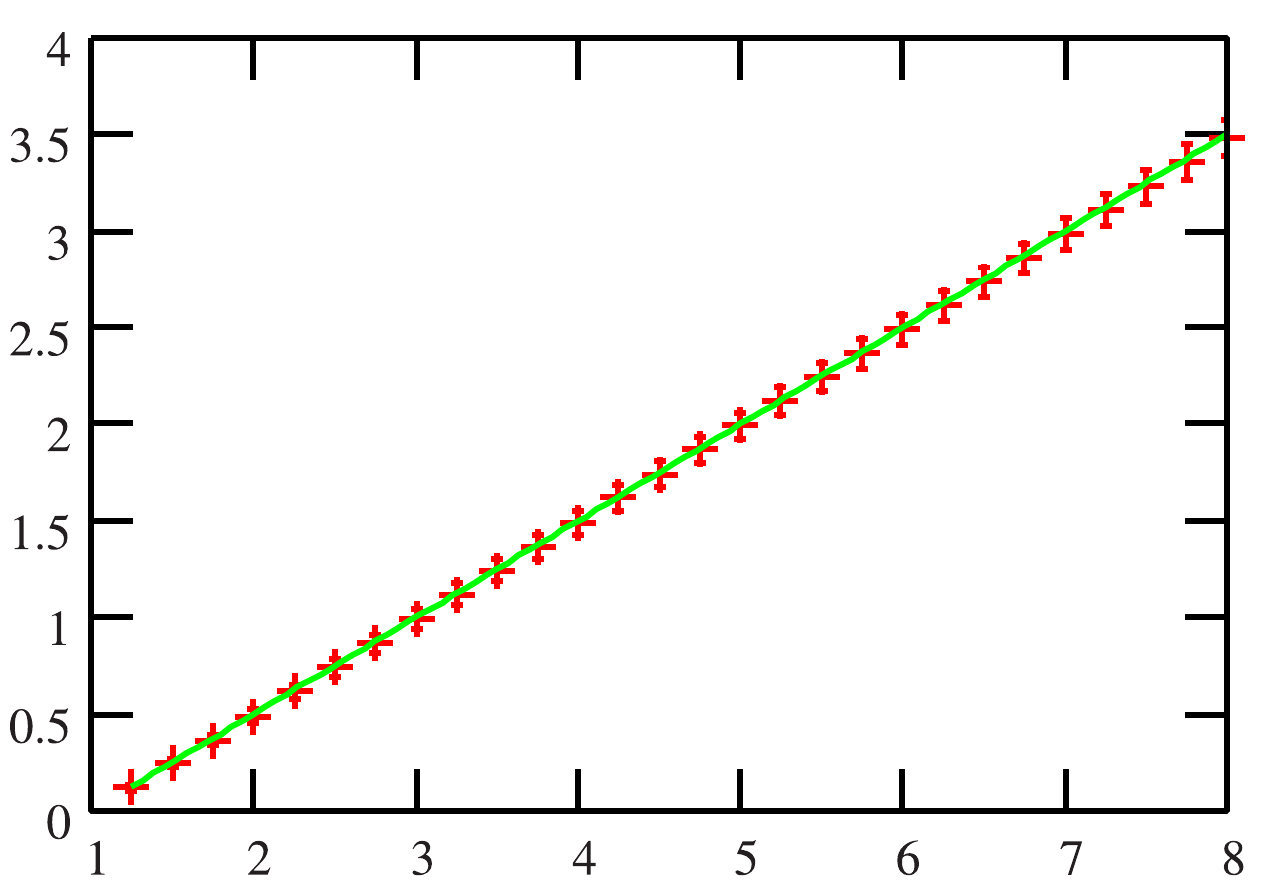
Fig 2. The reference ratio α (horizontal axis) versus one degree of the cost function ε (vertical axis). This result also indicates that the approximation approach based on probabilistic inference works